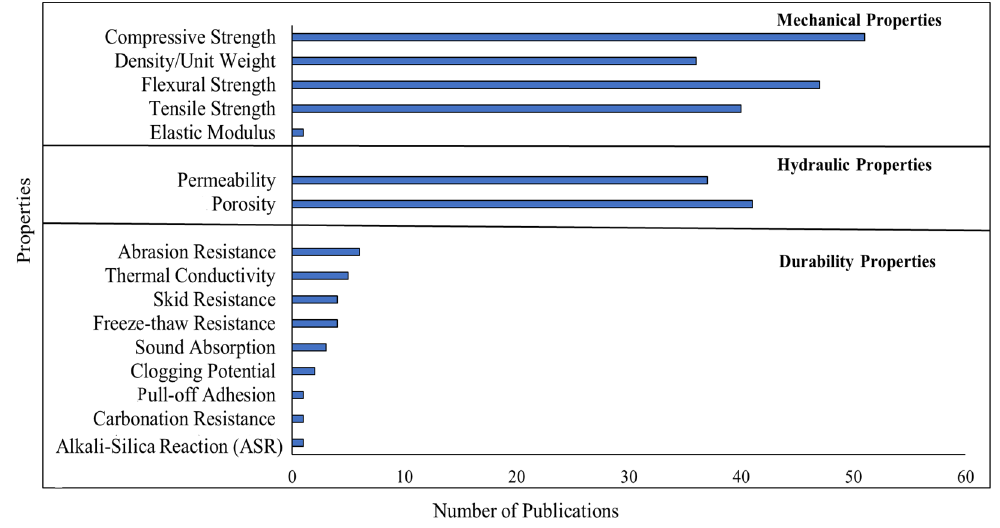
Figure 2. Number of studies conducted on the examination of various PC properties.